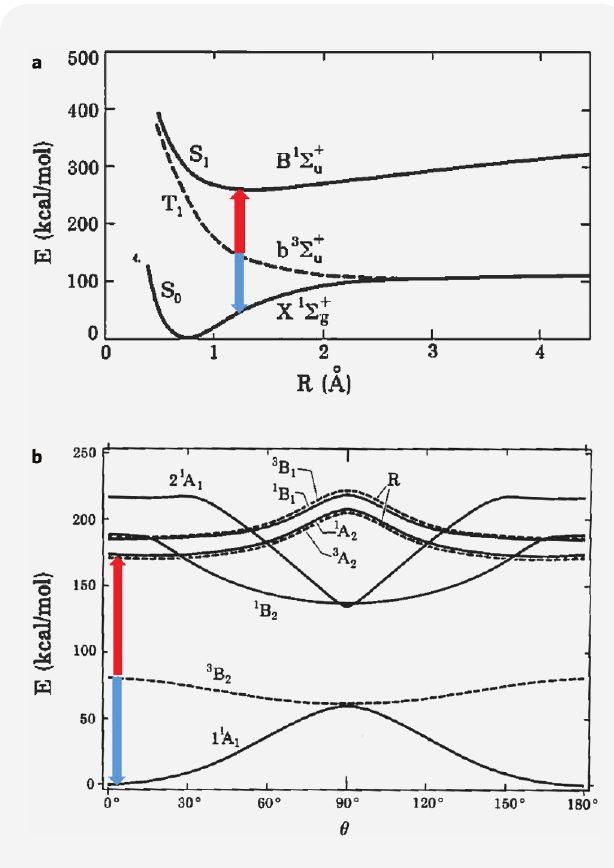
Figure 5. Equalizing T 1 -S 0 (blue) and T 1 -S 1 (red) separations by covalent pertur- bation of a perfect biradical. (a) Combining two H atoms. (b) Planarizing